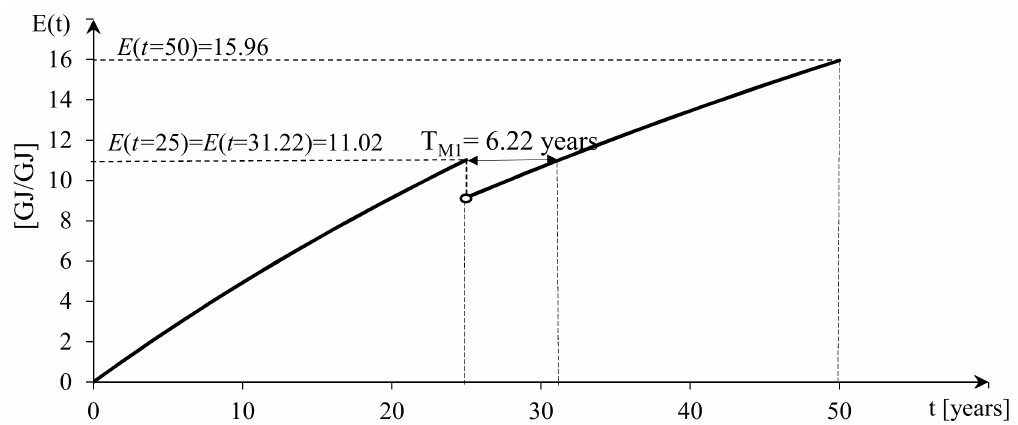
Figure 8. A graphical interpretation of the integrated e ffi ciency indicator from energy costs for a wind power plant undergoing modernization during a 50-year period of